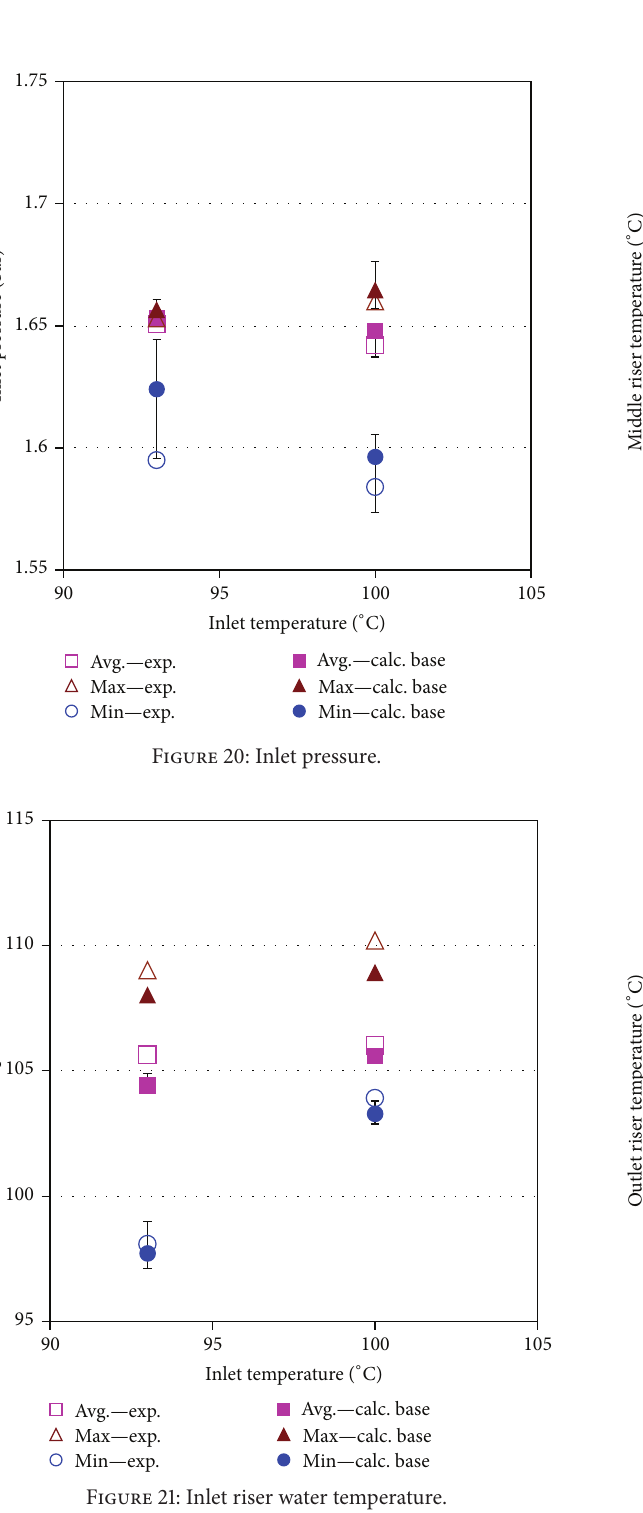
Figure 21: Inlet riser water temperature.